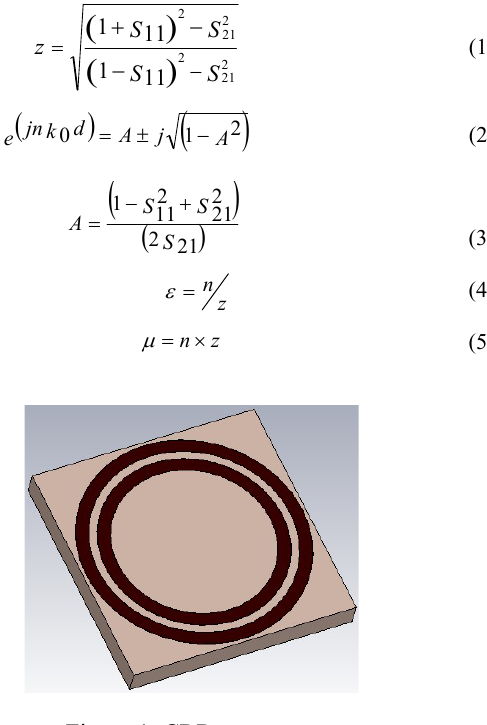
Figure 1: CRR structure.